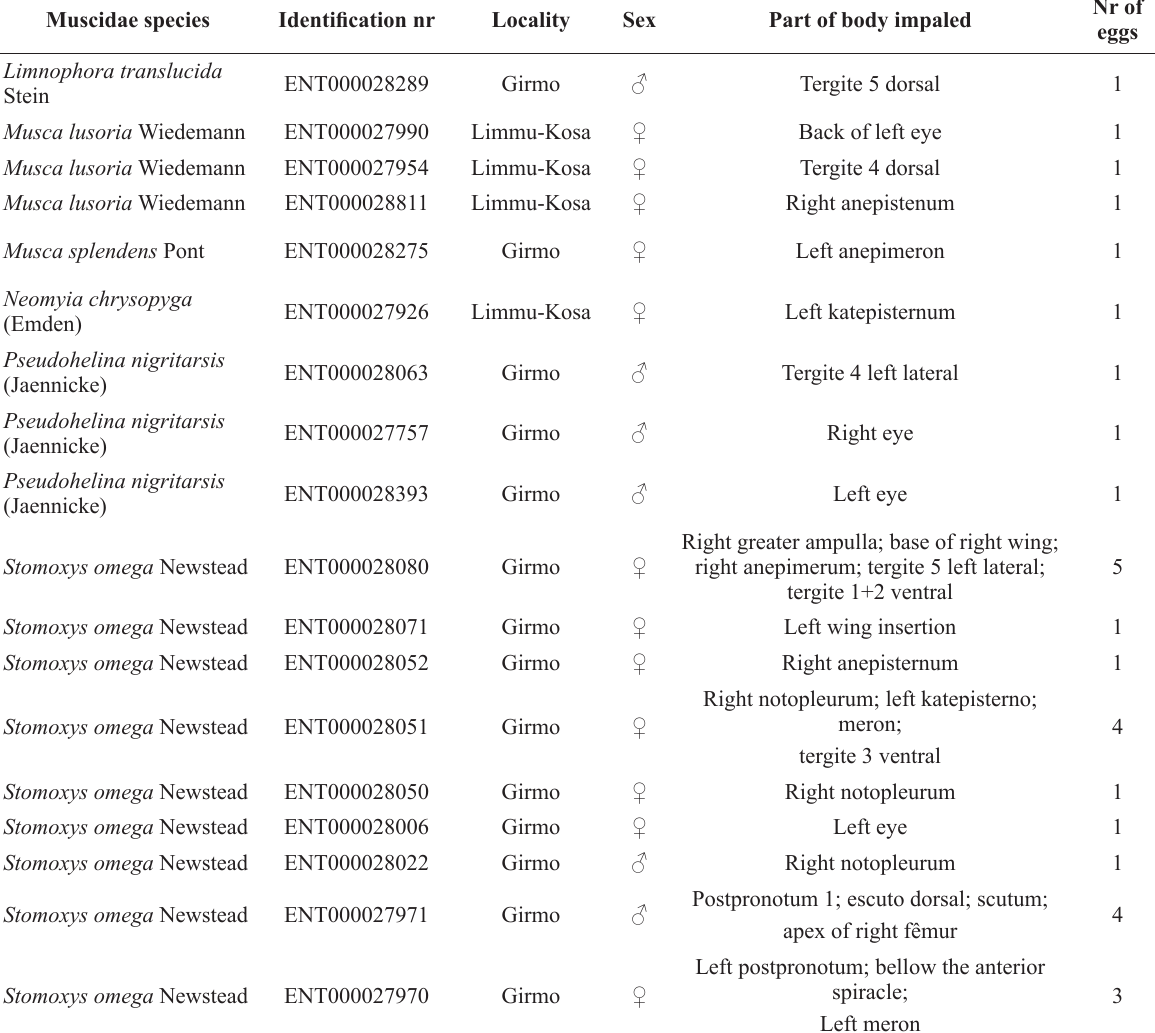
Muscidae host of Stylogaster spp. with details on number of eggs and body part where impaled were recorded. Muscidae